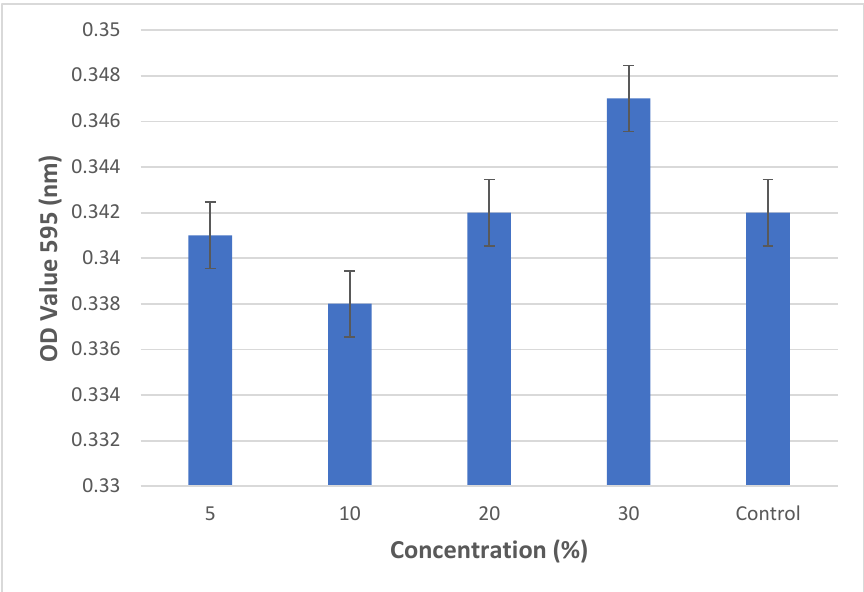
Figure 5. Cell viability assay after treatment with AgNPs for 24 h compared to control.